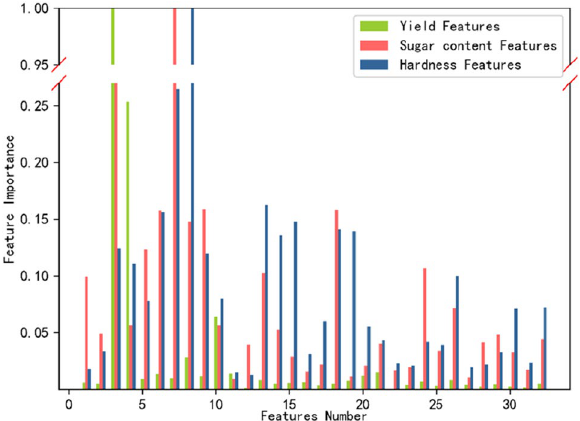
Figure 3. Importance of yield, sugar content, and hardness feature variables.